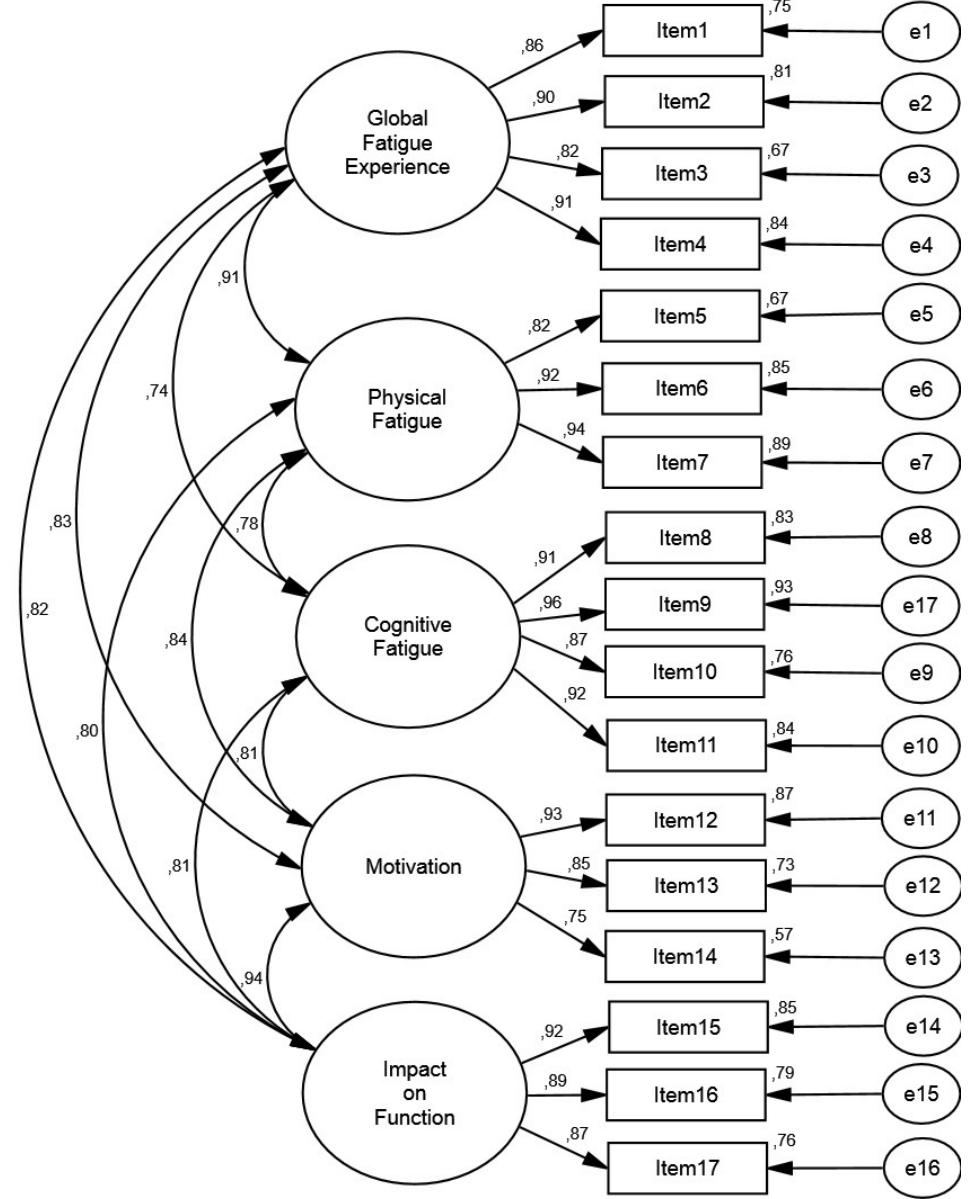
Figure 1. Measurement model in the Portuguese sample.